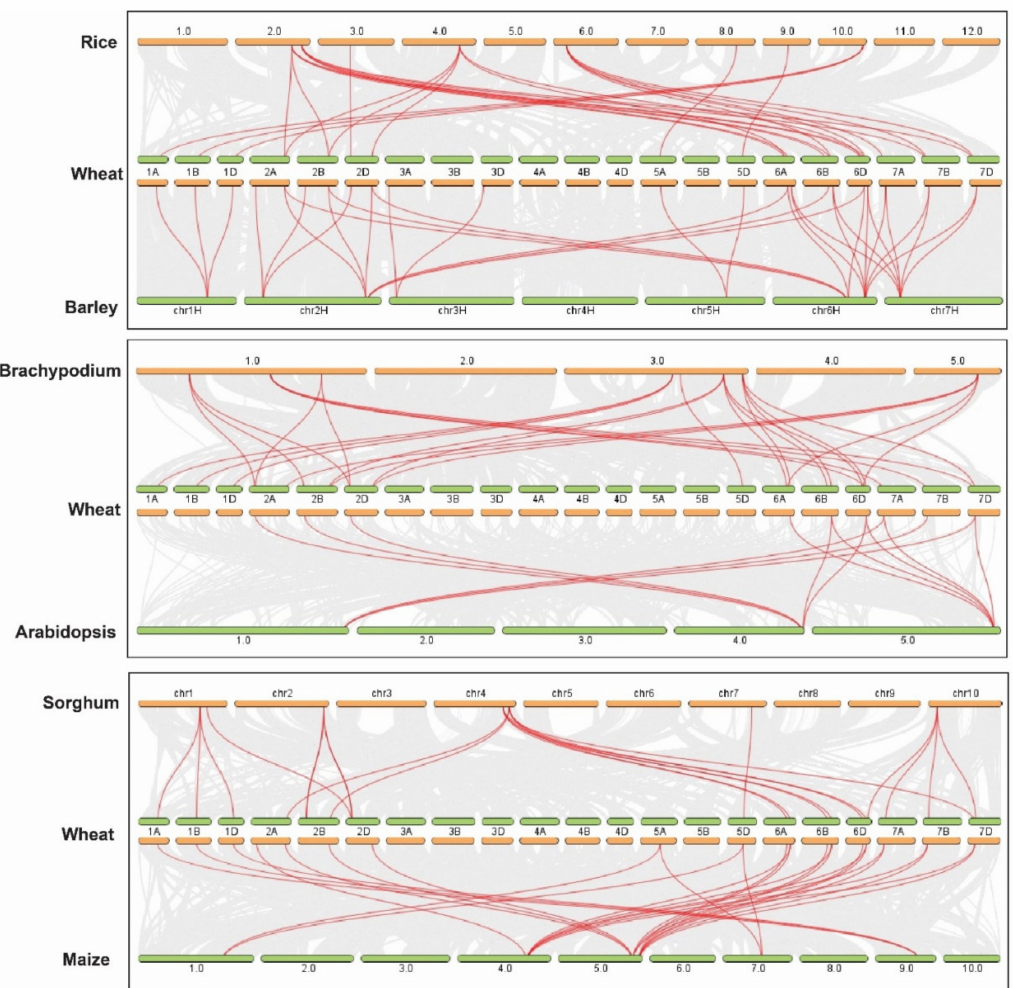
Figure 6. Syntenic relationship between TaTPPs with rice, Arabidopsis , Brachypodium, sorghum, and maize. The collinear blocks within wheat and other plant genomes are shown by gray lines in the background, while the syntenic TaTPP gene pairs are highlighted by red